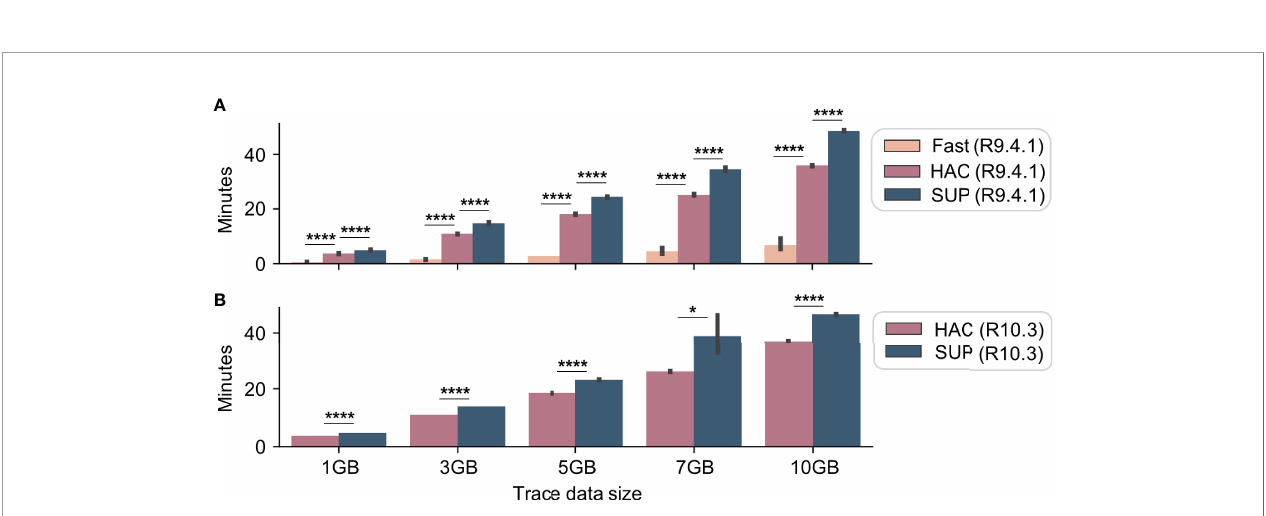
FIGURE 10 | HIV-Quasipore basecaller speed benchmarks. Benchmark experiments were performed to evaluate the basecalling speed of R9.4.1 (A) and R10.3 (B) HIV-Quasipore basecallers using 1, 3, 5, 7, and 10 GB datasets for four replicates. As expected, the HIV-Quasipore-fast was signi fi cantly faster than the HAC across all datasets. HIV-Quasipore-HAC was signi fi cantly faster than HIV-Quasipore-SUP (*p < 0.05, ****p < 0.00005). These results were consistent across fl ow cells.